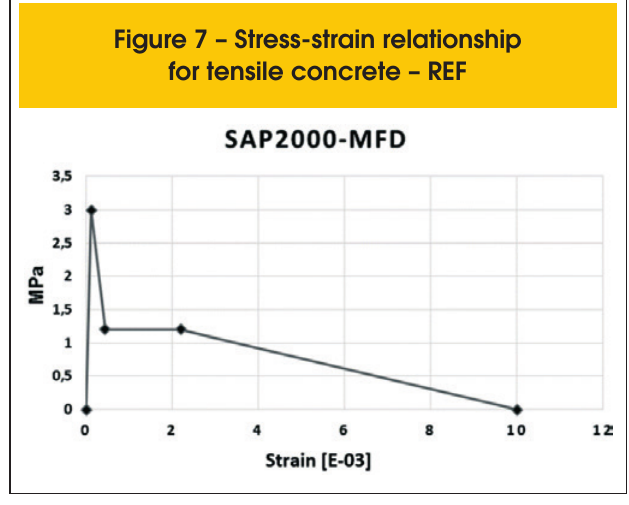
Figure 6 – Finite element mesh for ribs